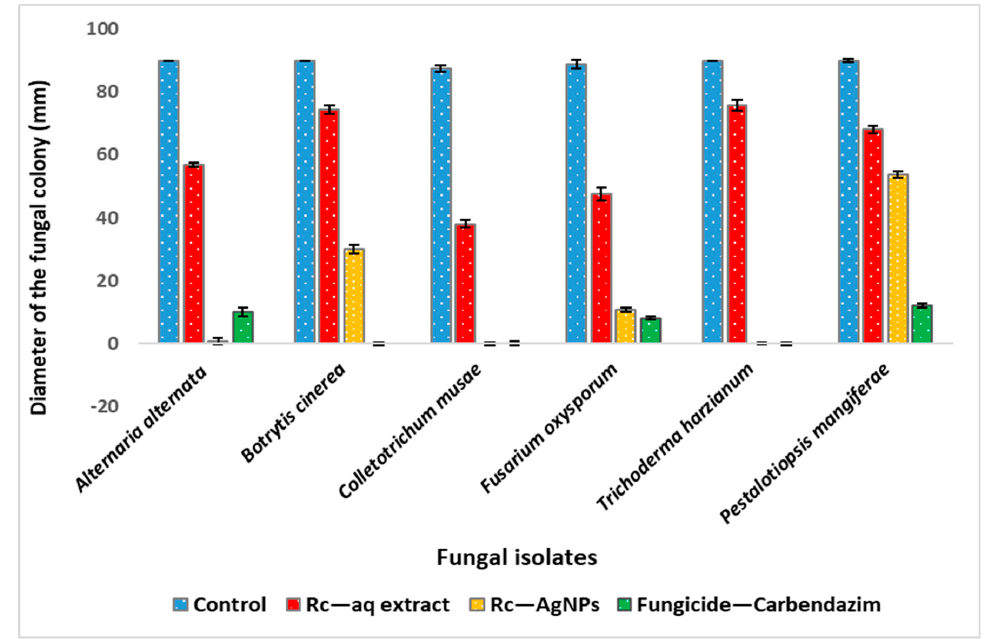
Figure 8. Diameter of the mycelial growth of fungal phytopathogens treated with red currant aqueous extracts, red currant-AgNPs, and the fungicide. The values depicted in the graph are an average (±SD) of three independent experimental replicates. Significant differences in means ( p ≤ 0.05) were determined by analysis of variance ANOVA and Turkey HSD.